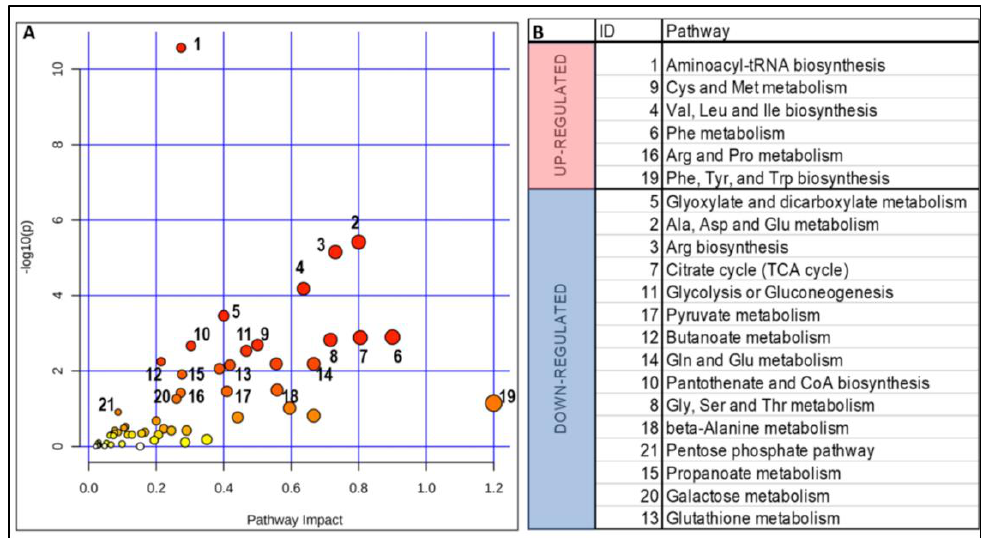
Figure 3. Omics-based pathway analysis of amniotic fluid. ( A ) Analysis was performed with the joint pathway module from MetaboAnalyst [38], which allows for an integrated approach to results obtained from combined metabolomics and protein expression studies conducted under the same experimental conditions. Enrichment analysis was based on the hypergeometric features and utilizing the topology based on the degree centrality (which evaluates the number of links that connect anode) within a pathway. The database utilized was KEGG, and the integration method combined the queries. Results were plotted as a function of impact within the pathway and significance. Labeled pathways have an FDR < 0.05. ( B ) Differentially expressed pathways in AF supernatants from carriers and non-carrier fetuses. These results were obtained by using the metabolomics and proteomics data (filtered by log2 FC >1 or < − 1 and p < 0.05) as input data, and analyzing them using the pathway modeling software PathVisio version 3.0 [39], which computes Z-scores as well as permutated p -values. This analysis was repeated utilizing proteomics data alone and employing the STRING database version 11, which specifically asks for proteome scale input, with each protein having an associated numerical value (log2 FC) [40]. Of the available methods for searching functional enrichments in such a set, we chose a permutation-based, non-parametric test that computes, for each protein set to be tested, the average of all values provided by our dataset for the constituent proteins. This average was then compared against averages of randomized gene sets of the same size. Multiple testing correction was applied separately within each functional classification framework (KEGG), in accordance with the method of Benjamini and Hochberg, but not across these frameworks, as there is significant overlap between